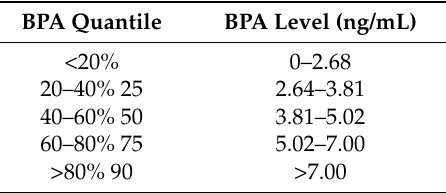
(Table 2) in order to evaluate the effect of different levels of exposure to BPA on TSH, fT4, SPINA-GT, TSHI and sTSHI within boys and girls, separately. Table 2. BPA quantiles of all participants.